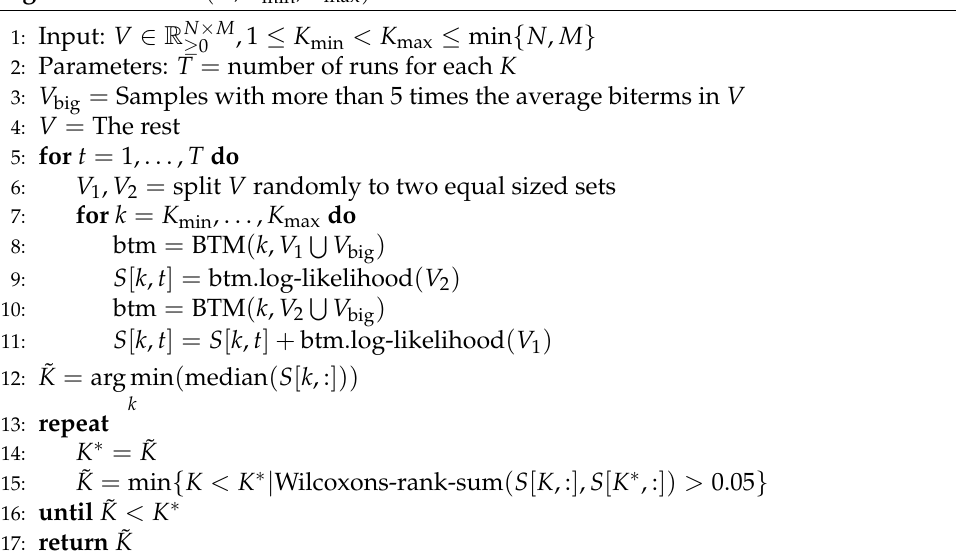
Algorithm 1 Btm2K ( V , K min , K max )